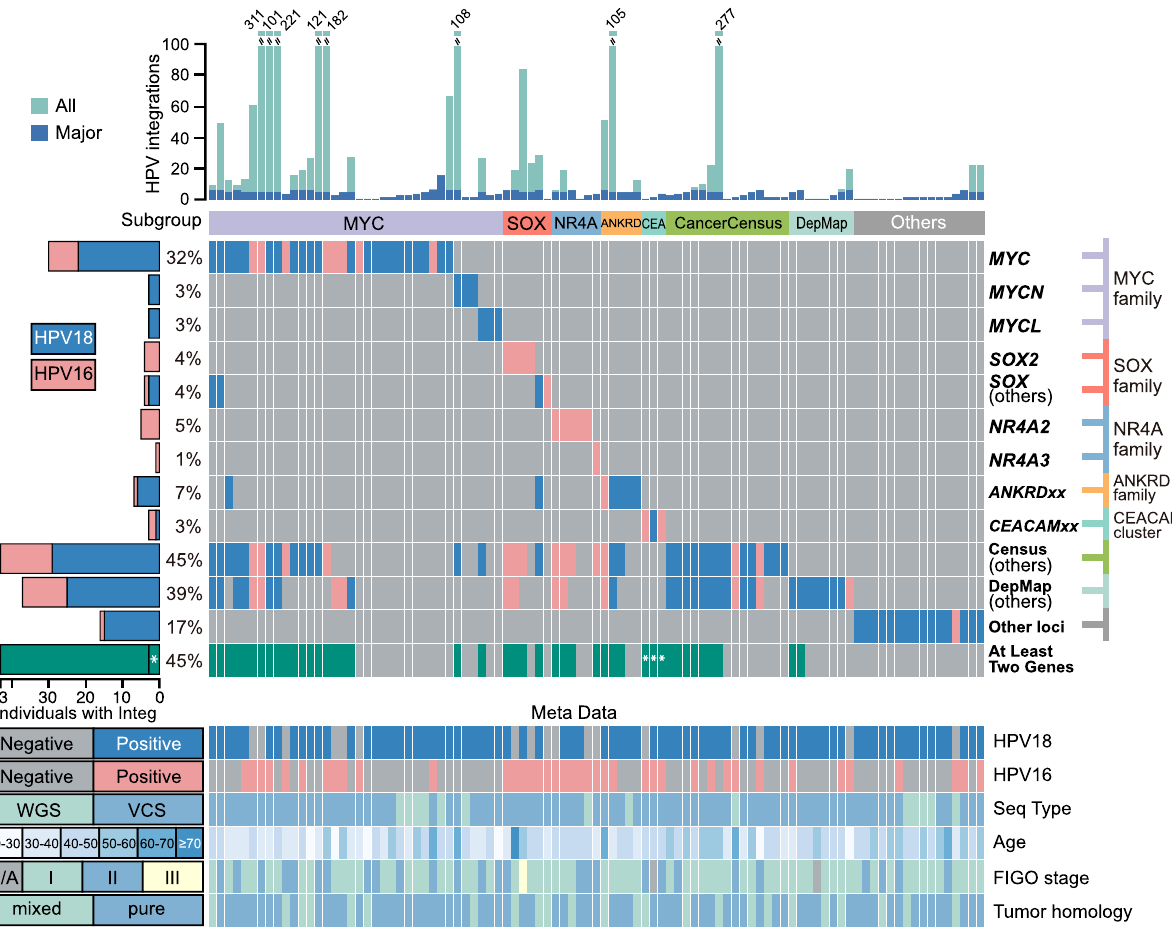
CancerDepMap (others) mean remains of the relevant gene groups, which did not include gene families mentioned above. Samples that have two or more HPV- integrated cancer-related genes are denoted, and CAECAM gene-cluster integrated samplesaremarkedbywriteasterisks.InfectionsofHPV16andHPV18inallsamples are denoted in Meta